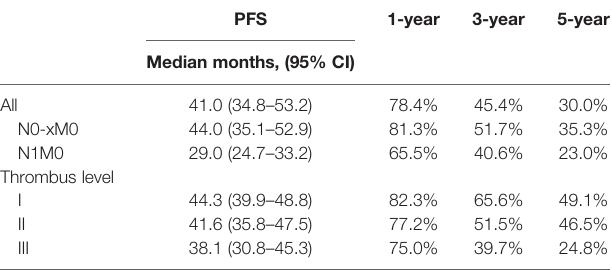
TABLE 3 | Progression-free survival of the study cohort and subgroup analysis.